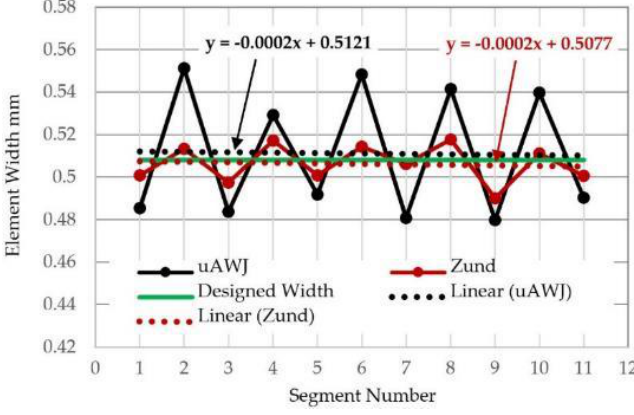
Figure 16. Average element widths of full-scale flexure (C-C and U-U) machining mode).